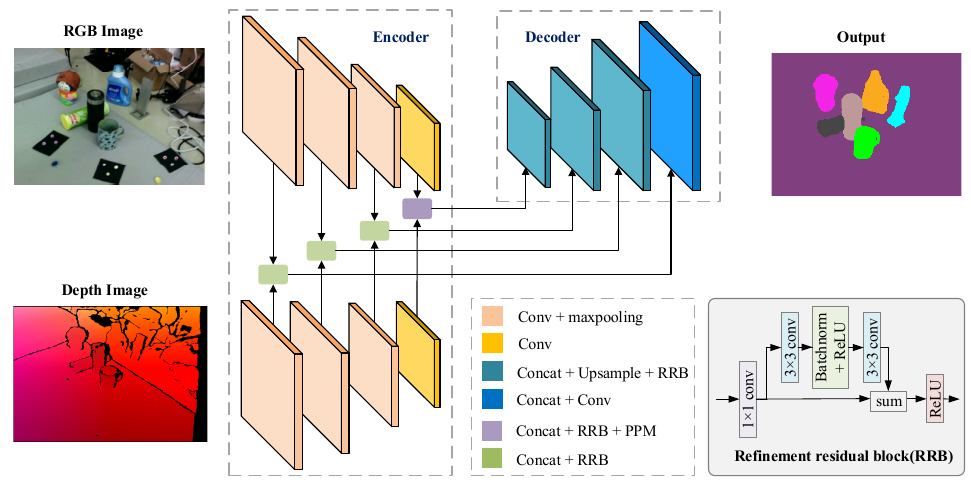
Figure 4. The overall framework of the segmentation network. The encoder network uses convolu- tional layers and MaxPooling layers to extract features of different scales from RGB and depth images. The decoder layer uses convolution and Upsampling to output pixel-level classification